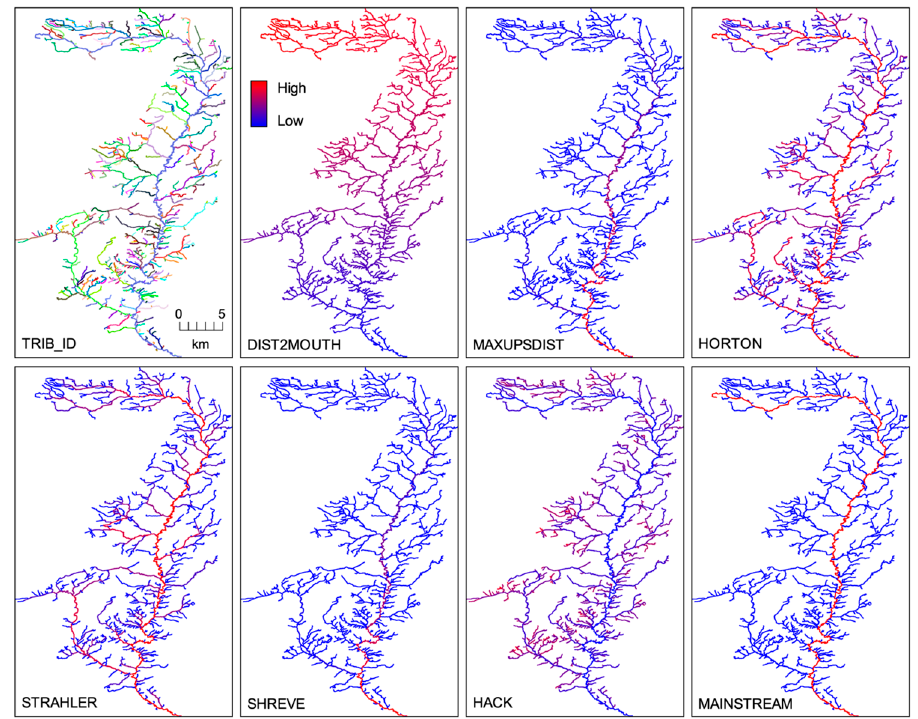
Figure 4. New Brunswick study area drainage network with line thickness proportional to Strahler stream order.